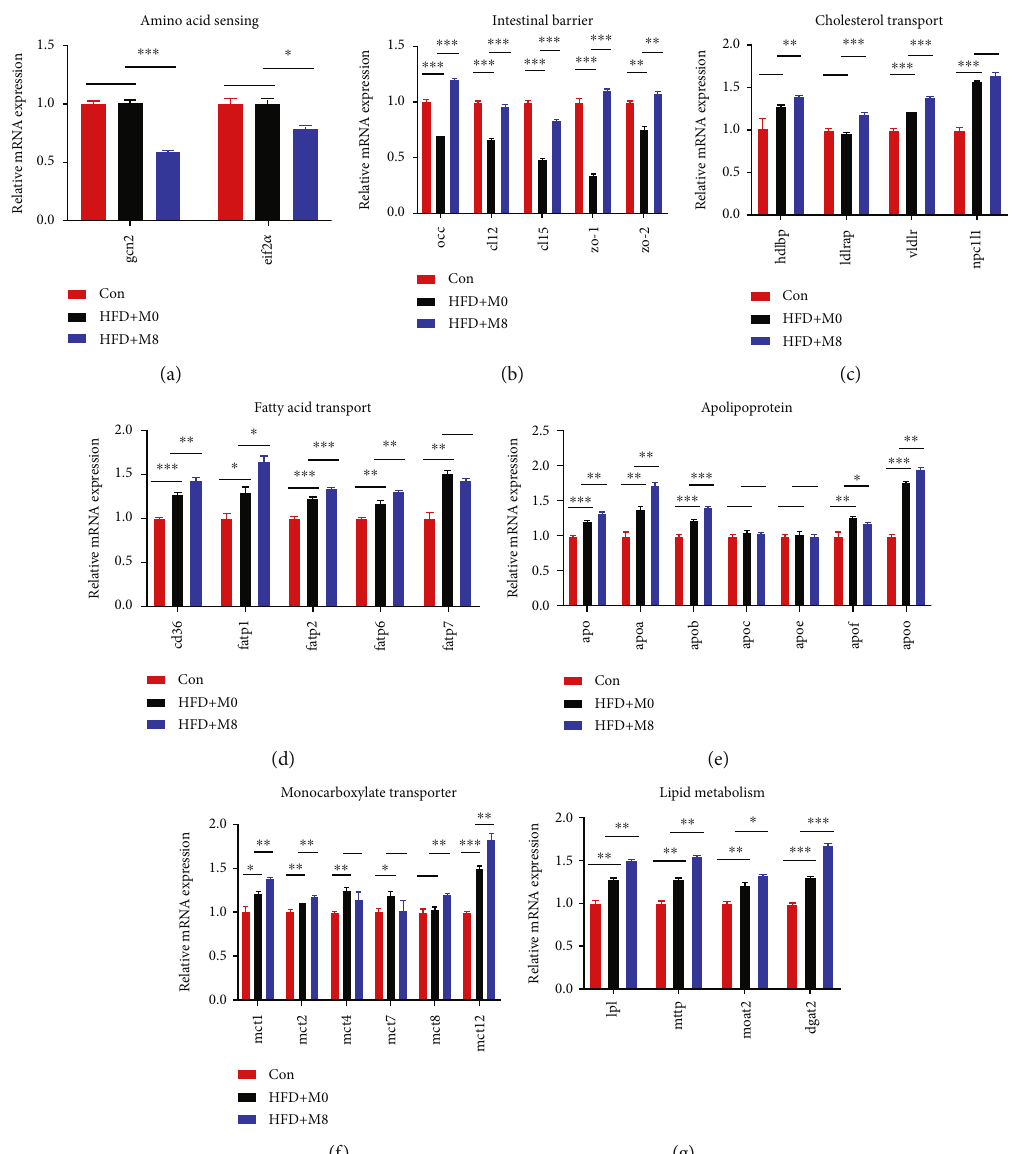
Figure 4: E ff ects of high-fat diet-supplemented methionine on intestinal mRNA expression ( n = 3 ), ∗ P < 0 : 05 , ∗∗ P < 0 : 01 , and ∗∗∗ P < 0 : 001 .